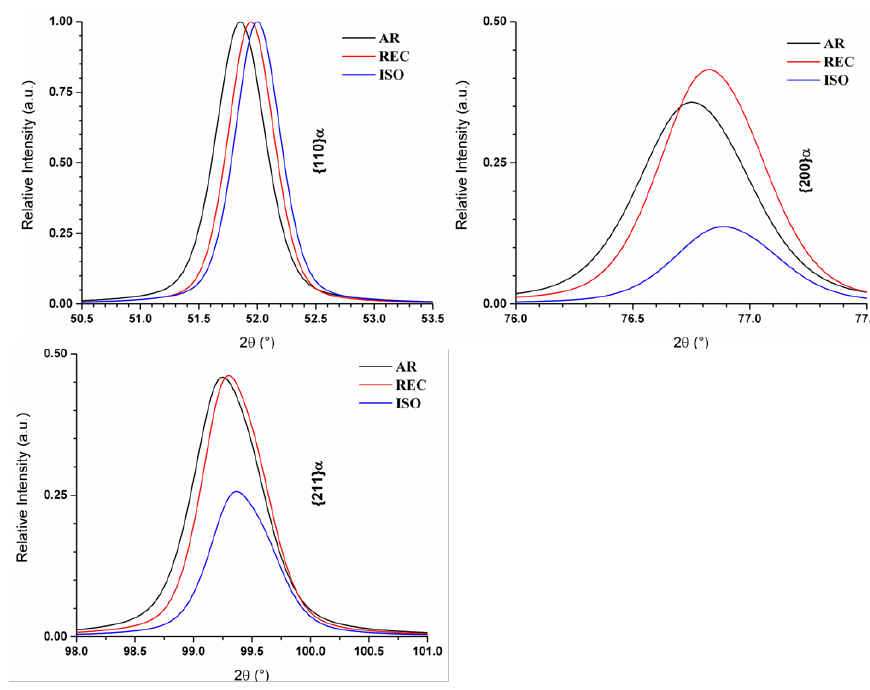
Figure 8. Comparison of peaks with AR sample.